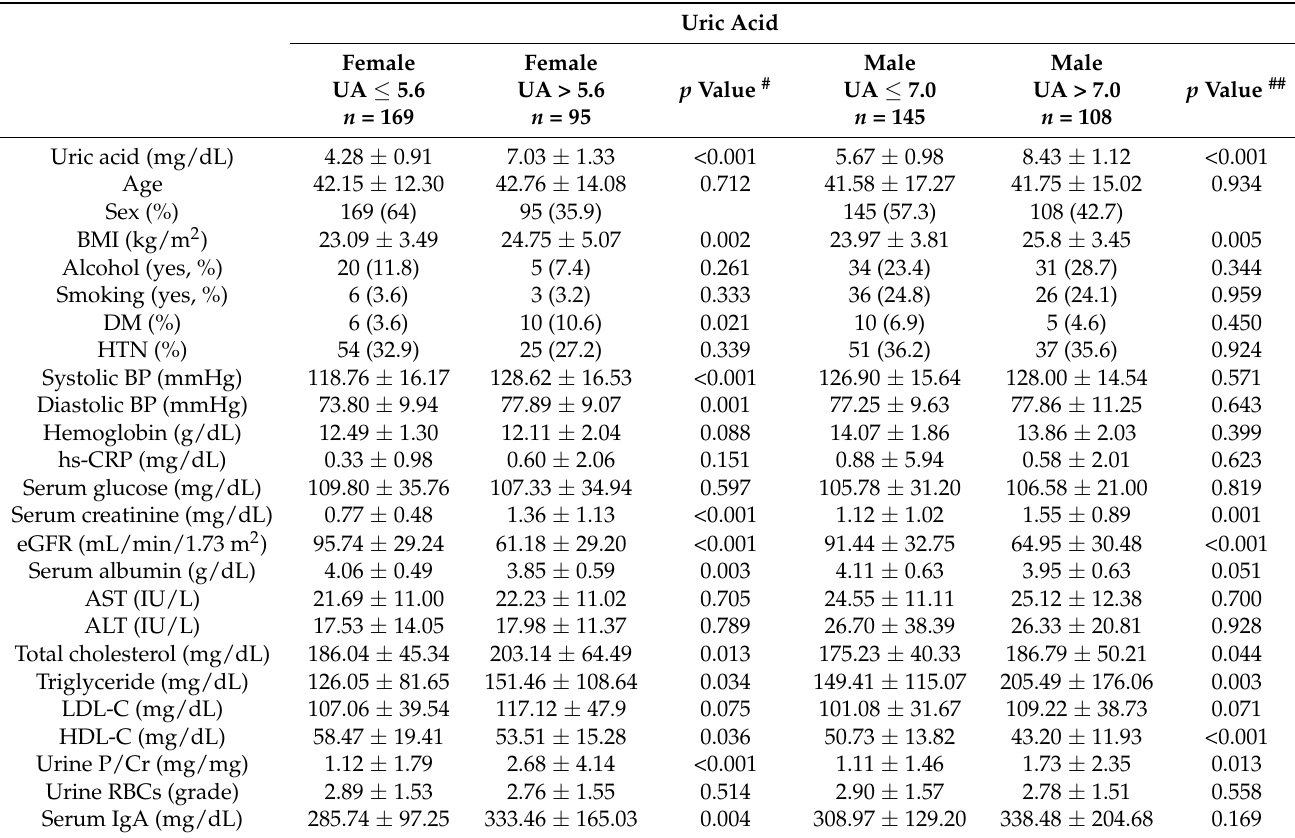
Table 2. Baseline clinical variables of the uric acid group at the time of renal biopsy. Comparison between normal UA and hyperuricemia in each female and male group